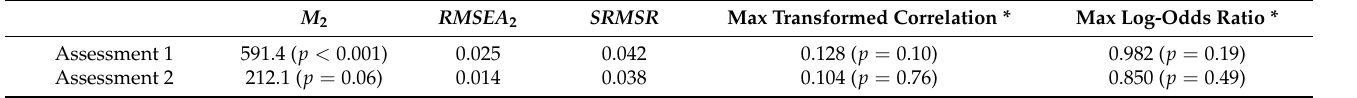
Table 4. Absolute fit statistics of the final models.